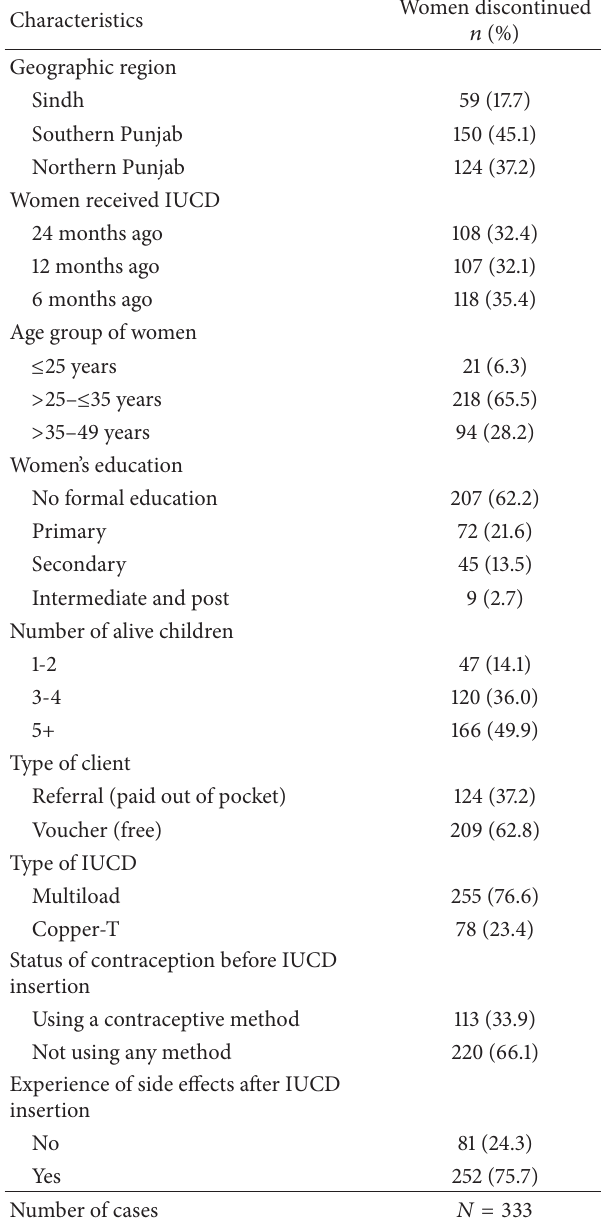
Table 1: Percentage distribution of women who removed IUCD due to any reason (other than pregnancy